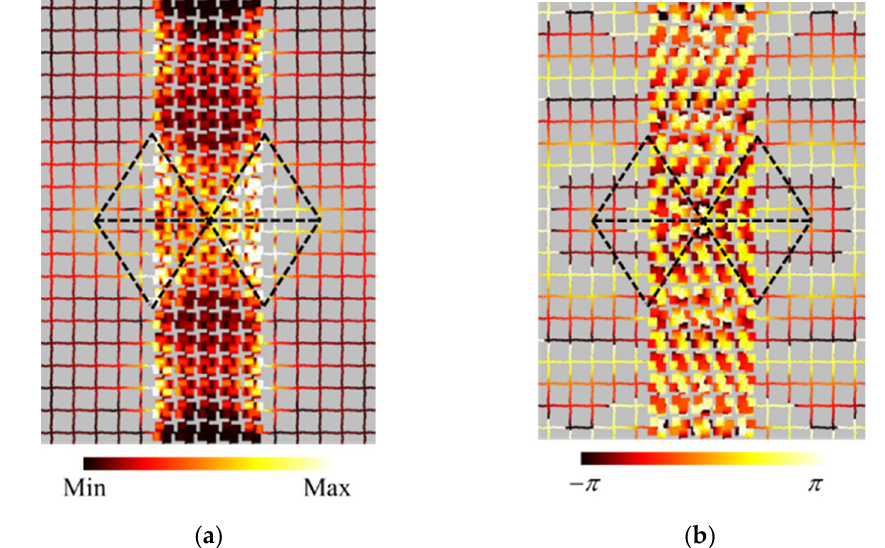
Figure 7. Calculated complex sound pressure distributions at 2.5 kHz. The wavelength is λ = 3.92 ∆ d NRI = 98.0 mm. The broken line represents an example of the theoretical trajectory of the incident acoustic wave from the source. The intersection of the line in the area of the designed NRI acoustic lens represents the theoretical position of the focus and that in the area of the right-hand side background medium represents the theoretical position of the refocus. ( a ) Amplitude; ( b ) Phase.